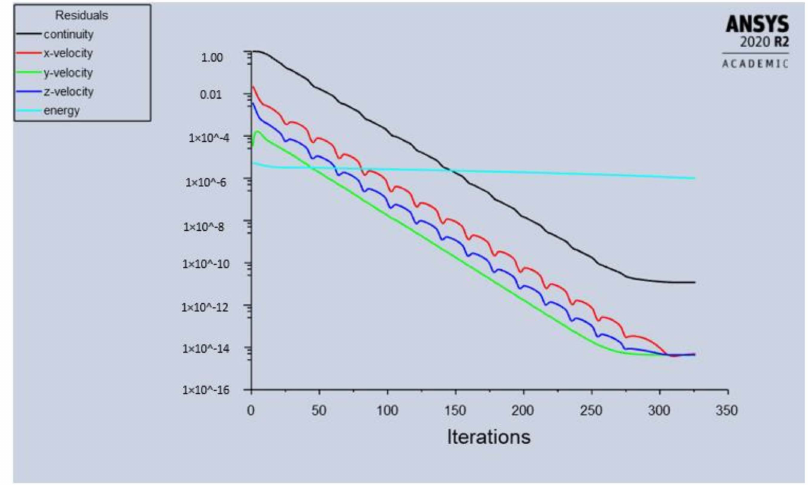
Figure 6. Converged residual plot for Design 1.